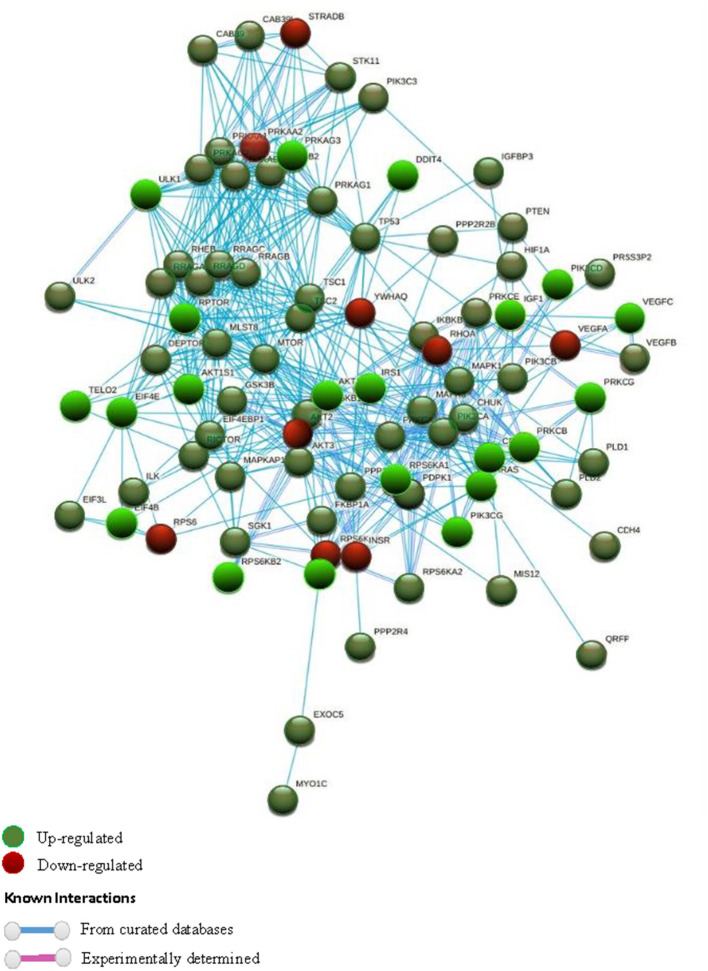
STRING interaction pathway of differentially expressed mTOR pathway genes. Green nodes indicate up-regulated genes and red nodes down-regulated genes comparing +AMR/+DSA and +DSA vs. –AMR/–DSA KT patients. The intensity of the color indicates the degree of regulation of the gene. The blue line shows that the interaction is checked against curated databases and the purple line shows that the interaction is experimentally determined.